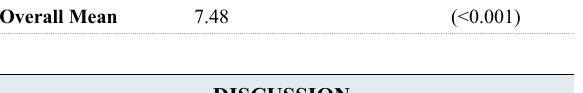
Table 3: Mean hospital stay among in comparison to CO CO level Mean hospital stay (days) p-value 2 Normocapnia 6.13 (SD± 2.13)